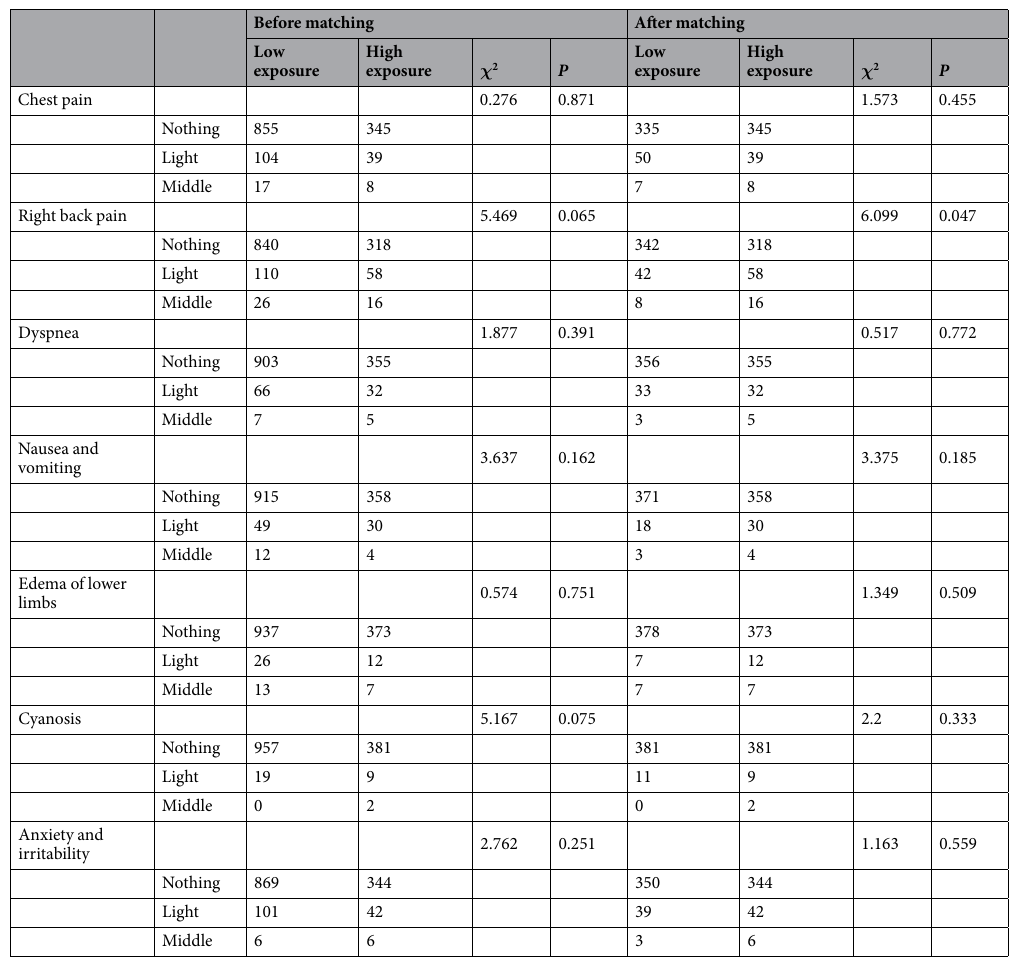
Table 5. Difference Test of Symptom Frequency in Cardiovascular System before and after